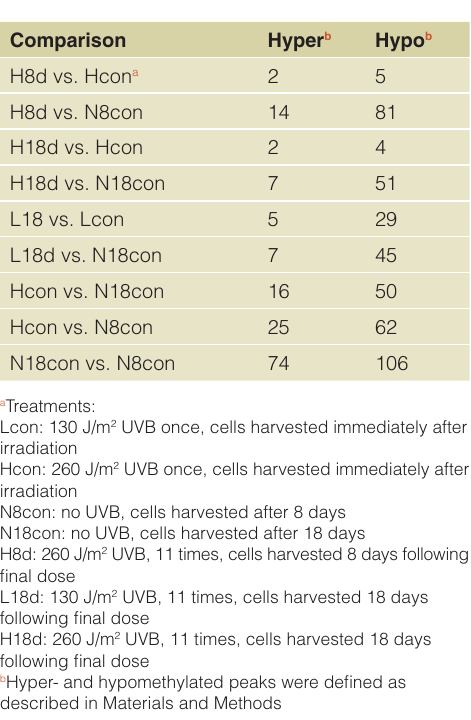
Table 1. Hypermethylated and hypomethylated candidate gene targets in human keratinocytes following UVB